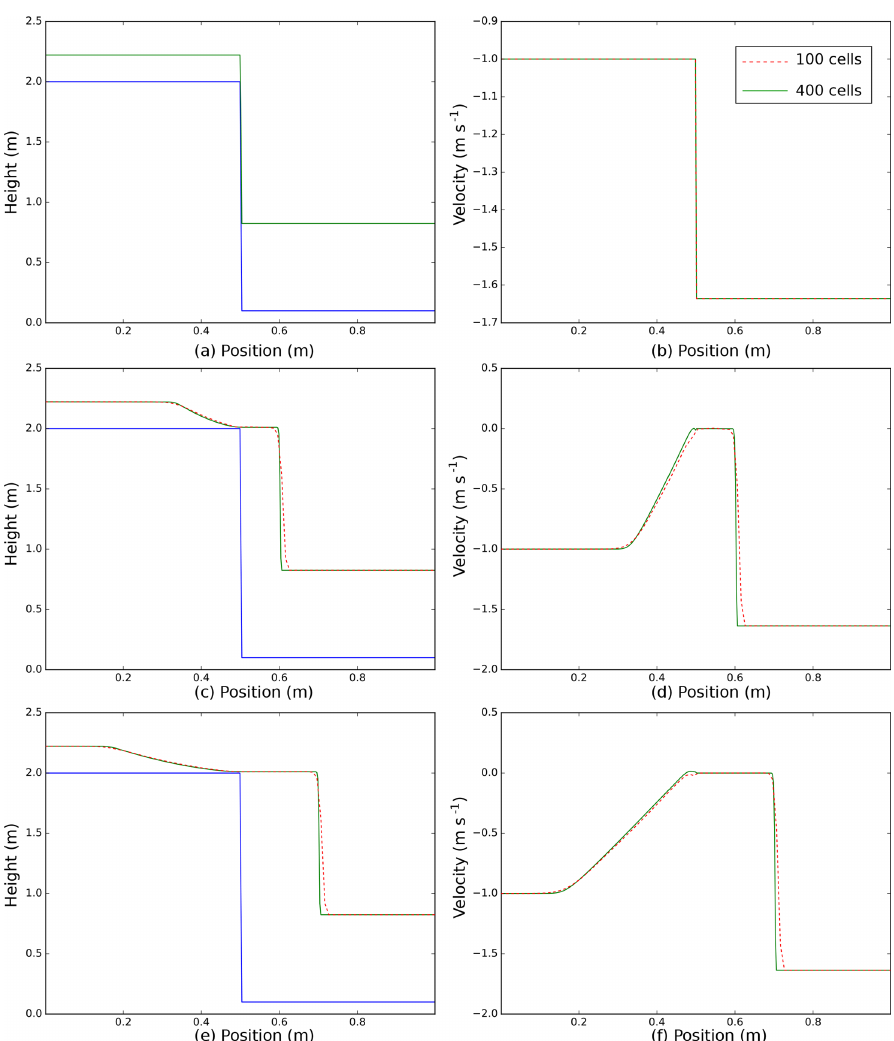
Figure 2. 1-D Riemann problem with no friction. Numerical solution at three different times: 0s (a, b) , 0.1s (c, d) , 0.2s (e, f) . Flow thickness and bottom topography (blue line) are plotted in the left panels, while the velocity is plotted in the right panels. The different colors represent numerical solutions obtained with different numbers of cells: 100 (dashed red line) and 400 (solid green line).